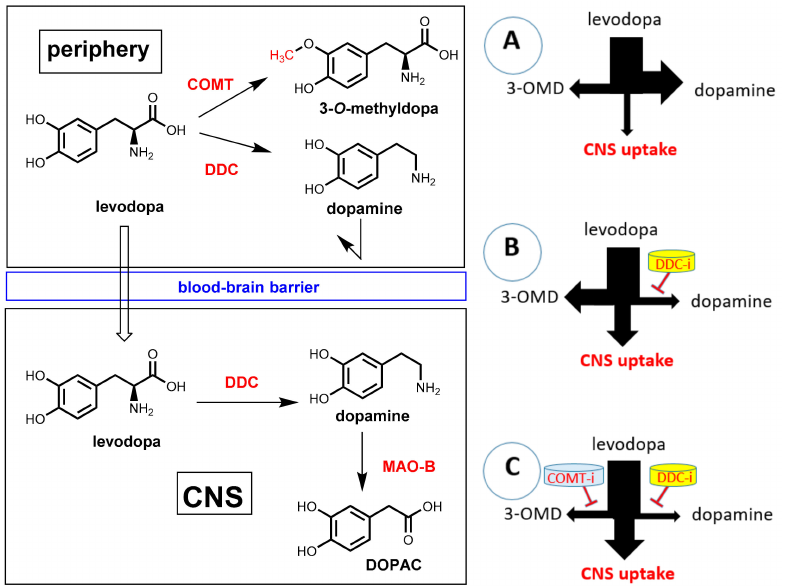
Figure 24. Transport and metabolism of levodopa. ( Left ): In the periphery, levodopa can undergo metabolism by both DOPA decarboxylase (DDC, AADC) or catechol- O -methyltransferase (COMT). Only unchanged levodopa is taken up into the brain. There it is decarboxylated by DDC to give the active compound dopamine. Dopamine is metabolized in the brain by monoamine oxidase B (MAO-B) as well as COMT and DDC (not shown in the graphic). ( Right ) ( A ): Application of levodopa without a pharmacokinetic enhancer results in extremely low uptake into the brain. The major part is lost by peripheral decarboxylation to give dopamine. ( B ): Co-administration of a DOPA decarboxylase inhibitor (inhibition indicated by a red bar) leads to significant enhancement of dopamine uptake into the brain, but by the action of peripheral COMT, 3- O -methyldopa (3-OMD) becomes the main peripheral metabolite. ( C ): Combination of levodopa with both a DOPA decarboxylase inhibitor and a COMT inhibitor (2 red bars) leads to a maximum uptake of levodopa into the